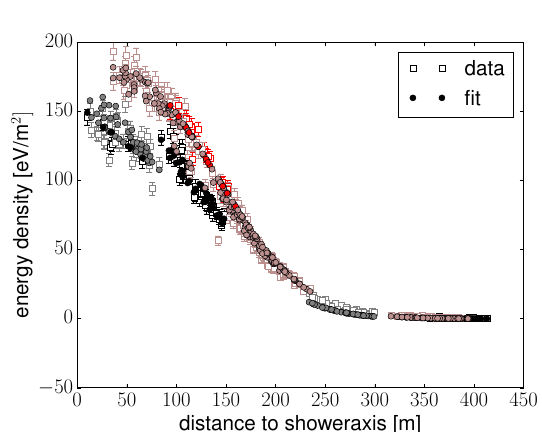
Figure 1. An example of a reconstructed air shower measured by LOFAR. The energy density is given as function of the distance to the shower axis. The colors indicate di ff erent azimuth angles. The red, pink, grey, and black points correspond to the northeast, southeast, southwest and northwest direction,